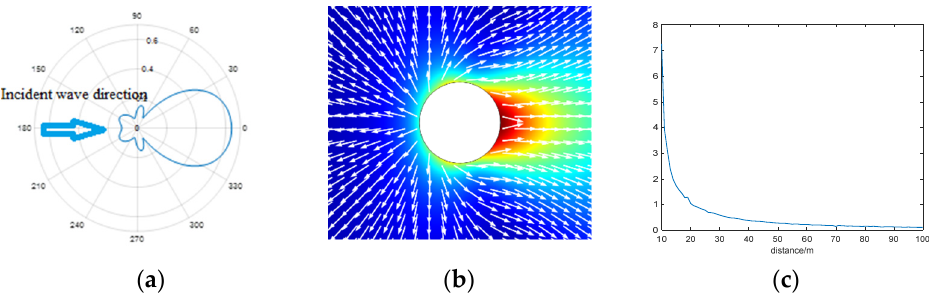
Figure 2. Scattering field of elastic spherical shell in free field under incident plane wave: ( a ) Far field sound scattering pressure directivity; ( b ) Near field scattered acoustic energy flow vector field; and, ( c ) Transverse-radial ratio of scattered sound energy flow in 0° direction.